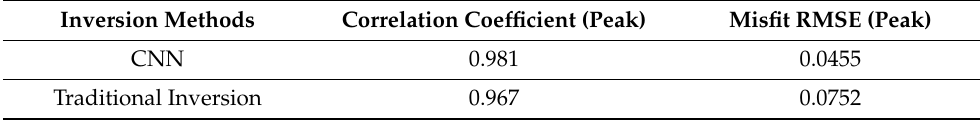
Table 2. The calculated R and RMSE using CNN and iterative inversion with 300 models.